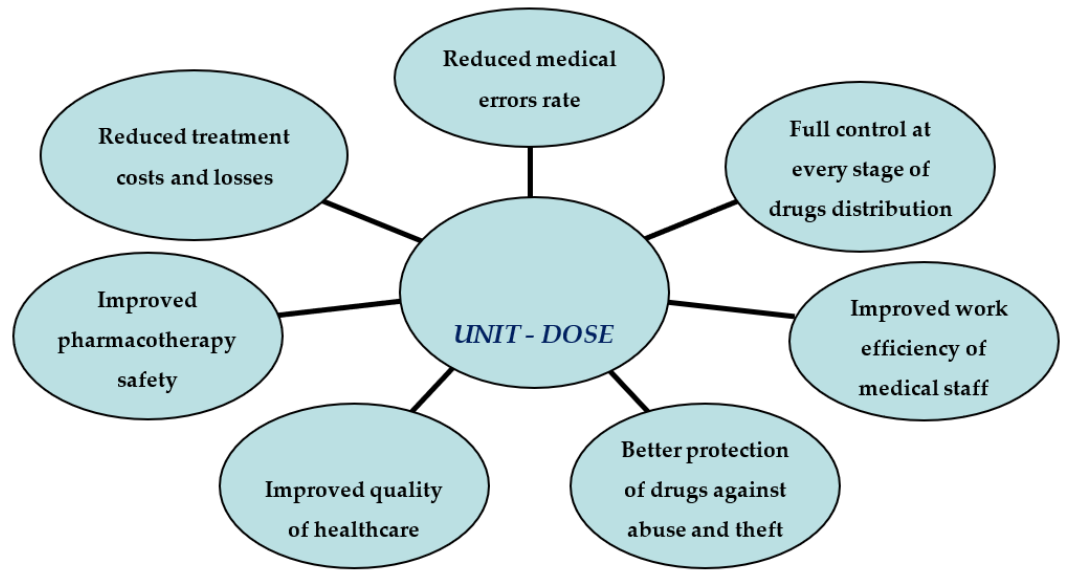
Figure 1. The advantages of implementing a unit ‐ dose system.